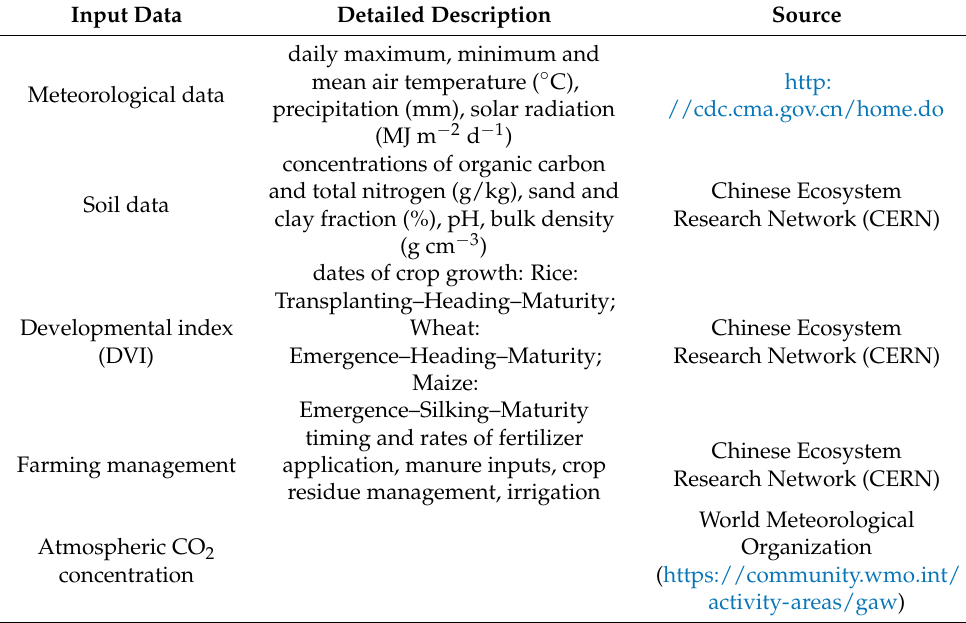
Table 3. Sources of input